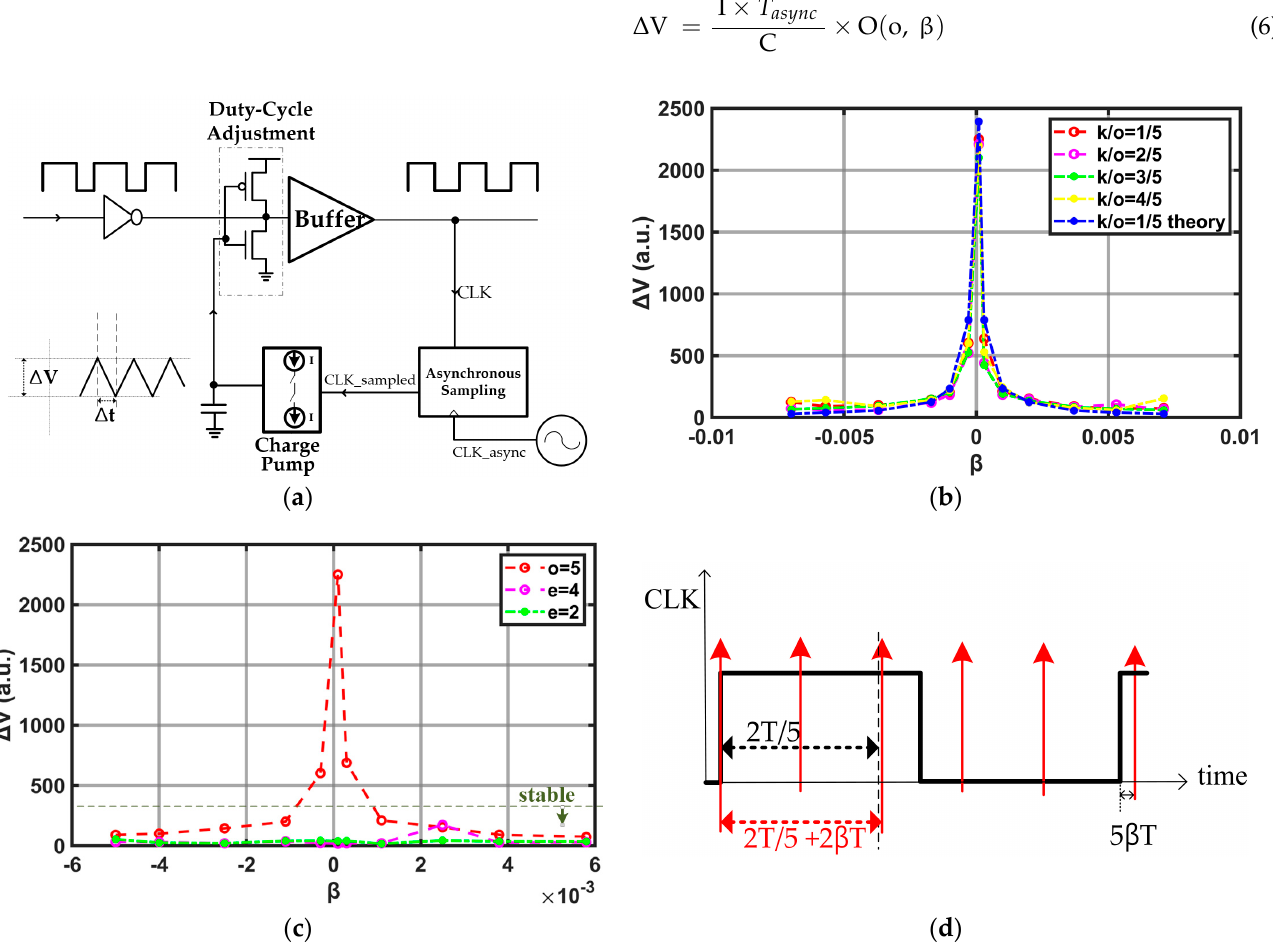
Figure 4. ( a ) Structure of a model of AS − DCC for measuring voltage variations. ( b ) Simulated and calculated peak − to − peak voltage variations for an odd − denominator condition (o = 5). ( c ) Simulated voltage variations according to odd and even denominators in α . ( d ) Timing diagram when o=5, and α = 2/5 + β (red arrows indicate the rising edges of CLK_async).